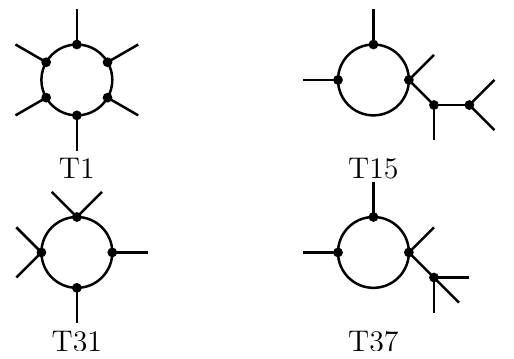
Figure 15 . Topologies that lead to a d = 5 1-loop neutrino mass. All diagrams generated from